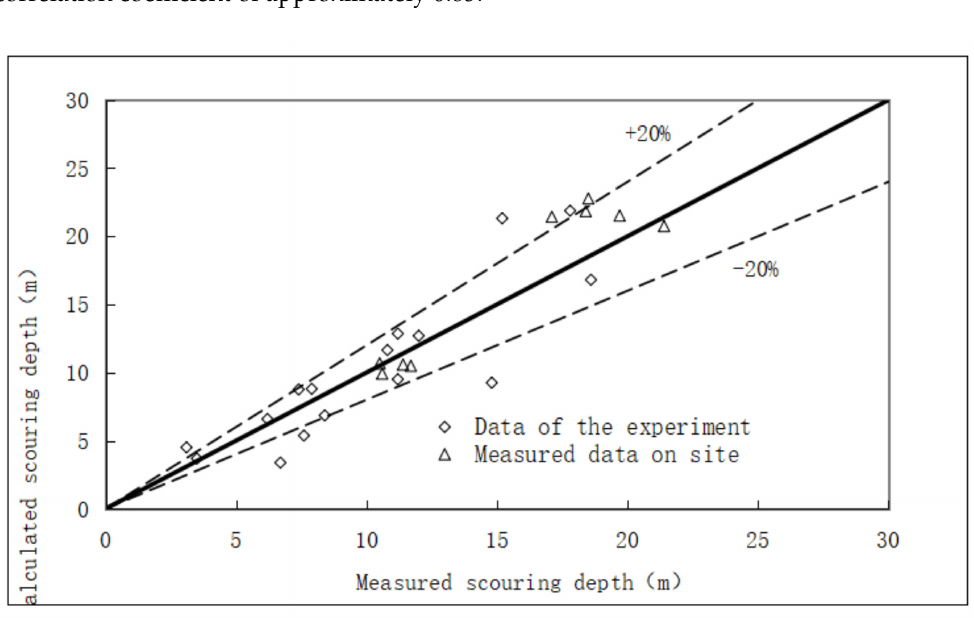
Figure 9. Comparison between experimentally measured values and formula-based computed values of local scouring depth of submerged spur dike